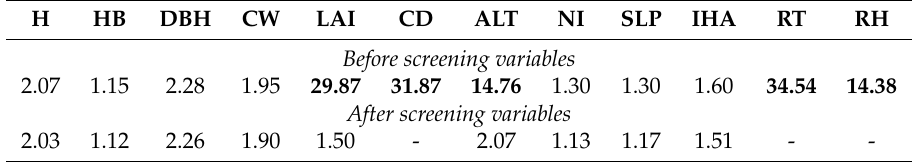
Table A2. The results of VIF before and after screening variables.